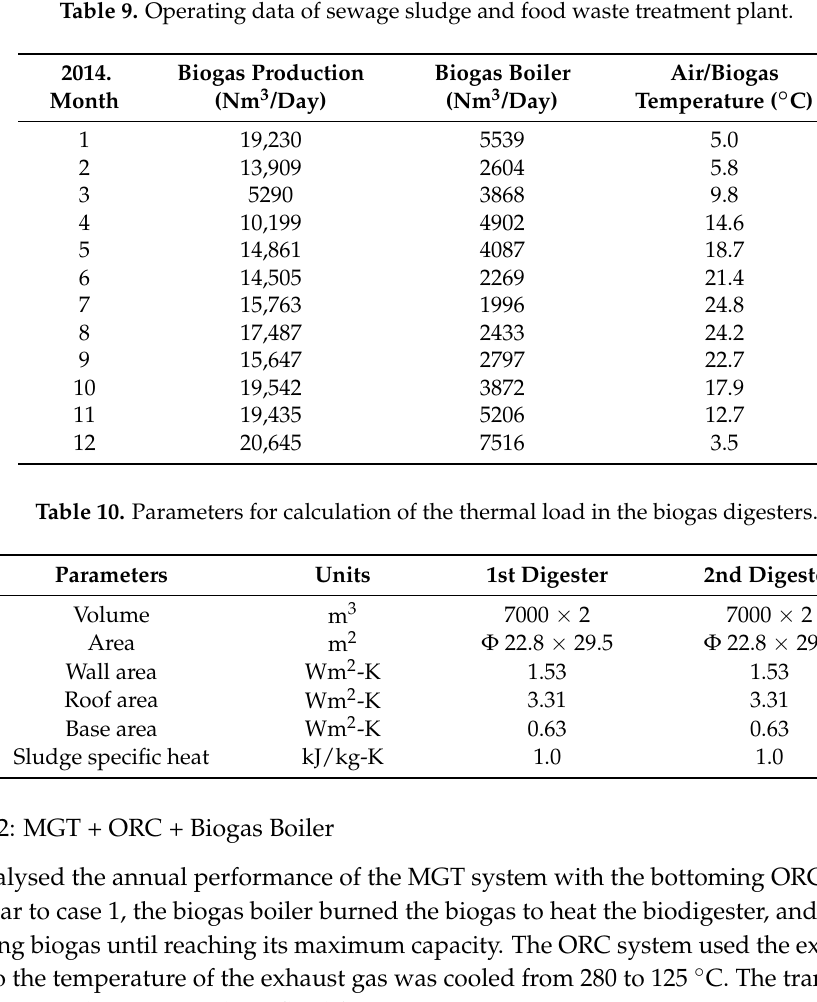
Table 9. Operating data of sewage sludge and food waste treatment plant.